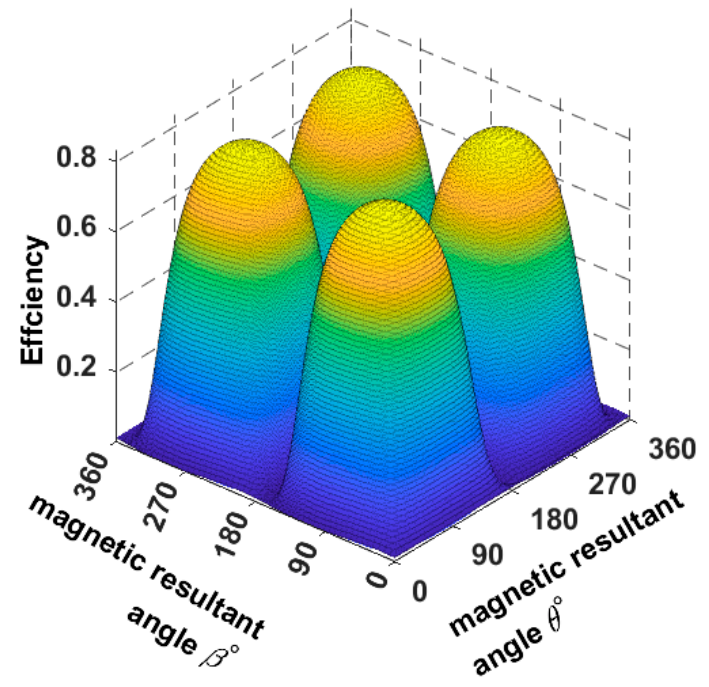
Figure 17. The system efficiency plot when the receiver is placed at 90°.